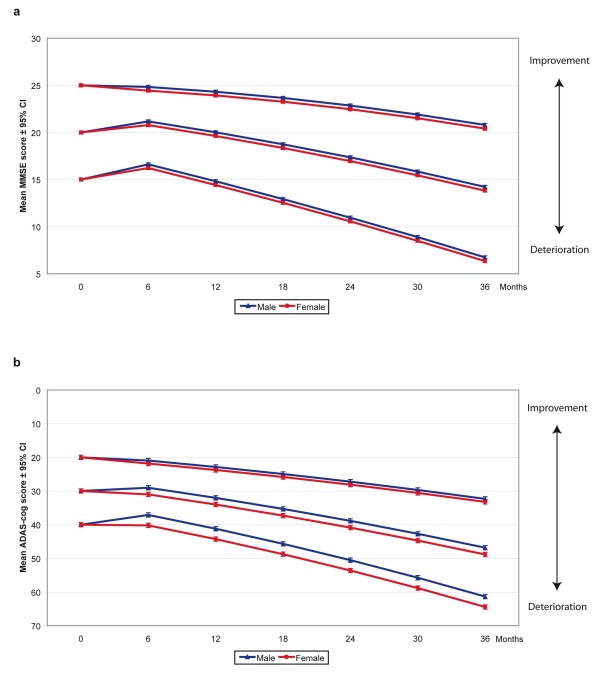
Cognitive outcome and gender. a) MMSE, prediction of outcome for different baseline scores divided by gender Three-year mean outcomes with 95% confidence intervals predicted by the mixed models for patients with different Mini-Mental State Examination (MMSE) scores (15, 20, and 25 were used as arbitrary examples), at the start of ChEI treatment and according to gender. Males demonstrated a better six-month treatment response compared with females (P = 0.010). The calculated outcomes were based on a 75-year-old patient who did not receive NSAID/acetylsalicylic acid treatment, had nine years of education, exhibited an IADL baseline score of 16, and received 65% of the maximum recommended dose of ChEI. b) ADAS-cog, prediction of outcome for different baseline scores divided by gender. Three-year mean outcomes with 95% confidence intervals predicted by the models for patients with different Alzheimer's Disease Assessment Scale-cognitive subscale (ADAS-cog) scores (20, 30, and 40 were used as arbitrary examples), at the start of treatment and according to gender. Male subjects showed a better response to treatment compared with females. An interaction effect of ADAS-cog baseline score × Gender was detected (P = 0.015), that is, the difference between genders increased with lower baseline scores. The calculated outcomes were based on a 75-year-old patient who was an APOE ε4 carrier, did not receive NSAID/acetylsalicylic acid treatment, had nine years of education, exhibited an IADL baseline score of 16, and received 65% of the maximum recommended dose of ChEI.